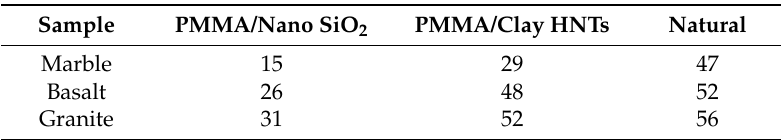
Table 4. The weight residues, W %, for the prepared artificial stones and natural stones after heating to 1400 ◦ C in a nitrogen